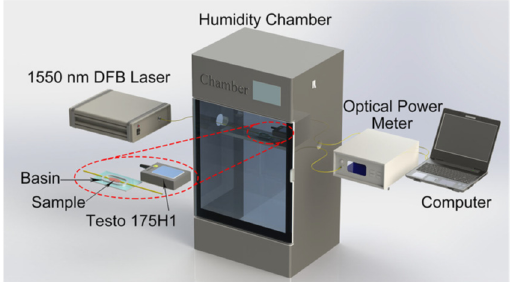
Figure 32. Point sensor. Schematic of relative power measurement of optical microfiber overlaid with niobium disulfide. Reprinted with permission from ref. [172]. Copyright 2020 Springer